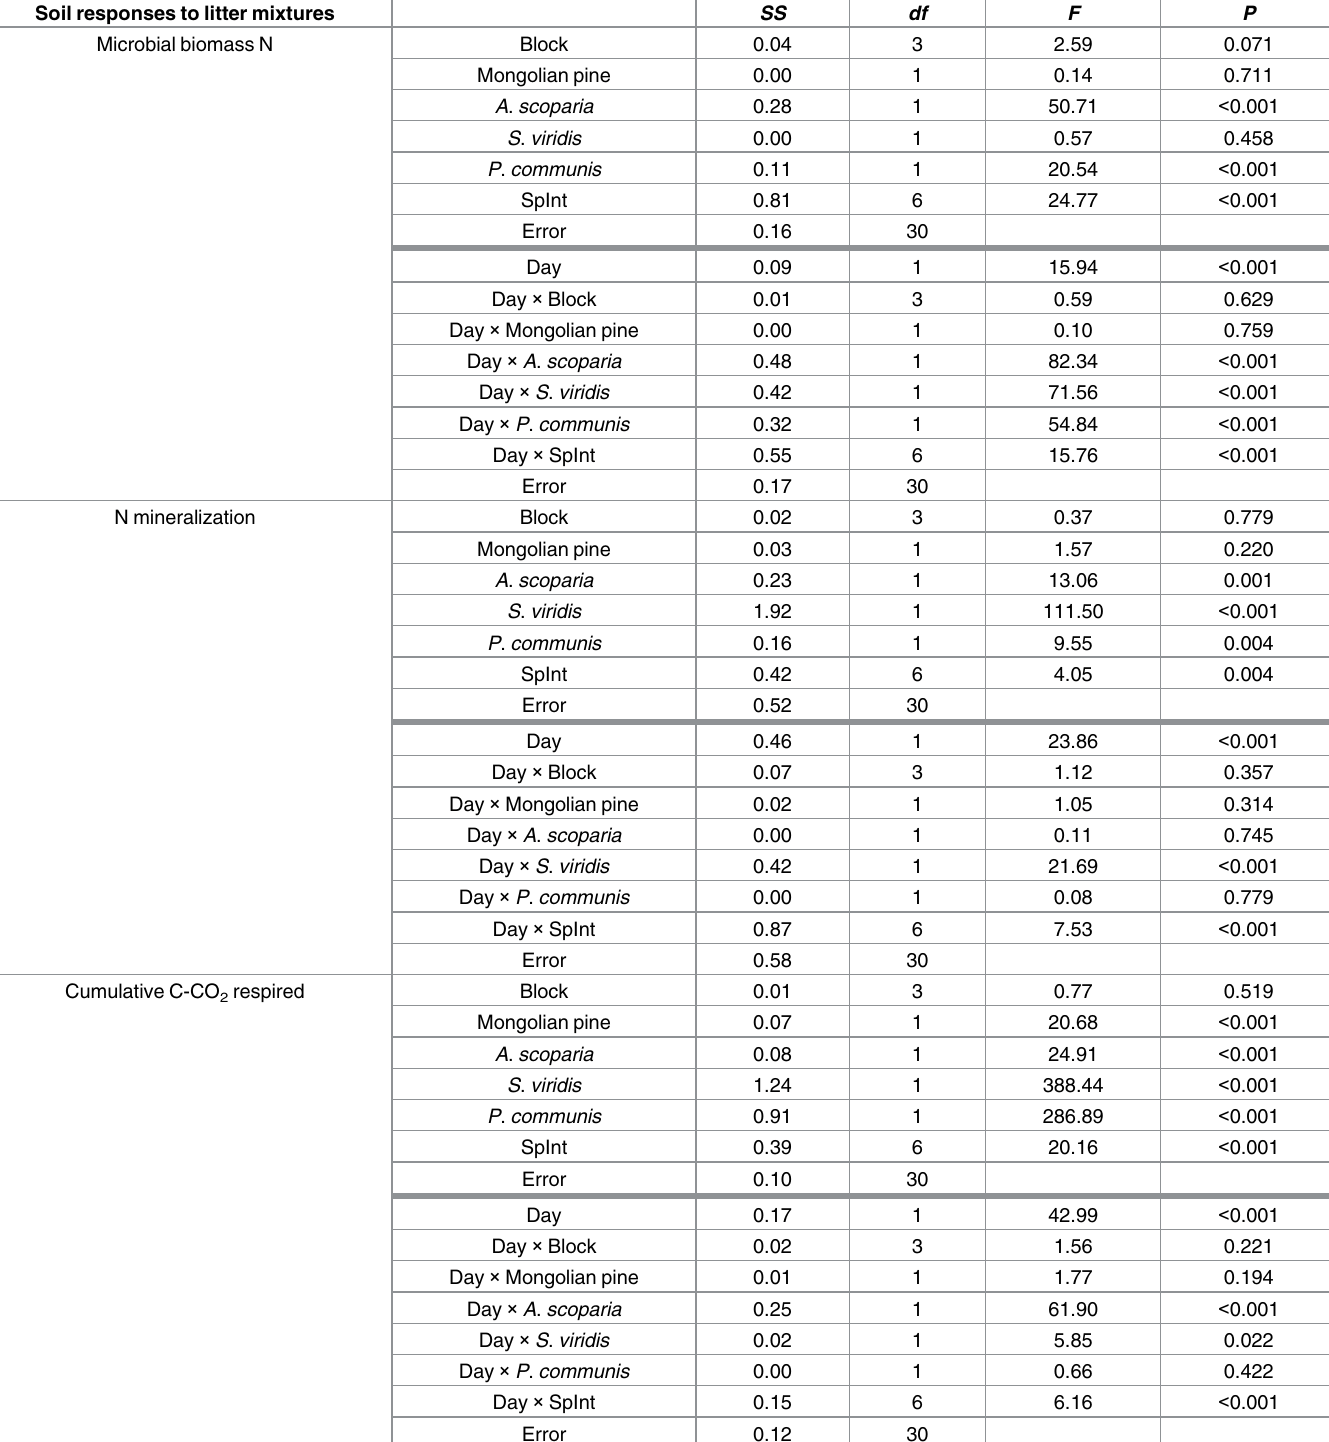
Table 2. Summaryof the ANOVA’s test for additive and non-additive effectsof species mixing on soil microbial biomass N, soil net N mineraliza- tion and soil respiration using Type I sums of squares (SS). Soil responses to litter